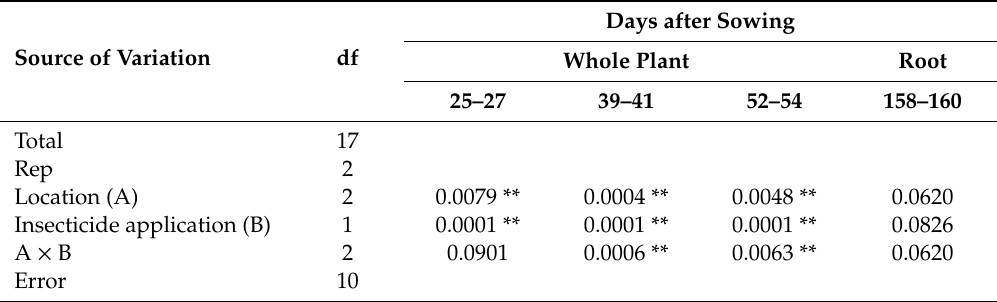
Table 4. Imidacloprid residues in the whole sugar beet plants during the first three observing periods and for roots at harvesting in 2015.